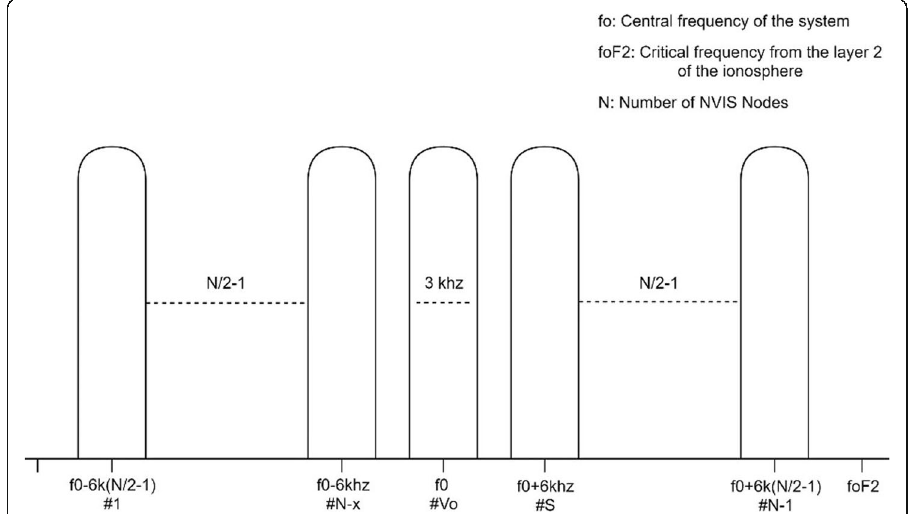
Fig. 12 Frequency channel distribution. This figure defines the channel frequency distribution and the channel bandwidth depending on the number of NVIS nodes installed in a supposed scenario. Also, we can see some specifics channels used for NVIS network management (#fo,